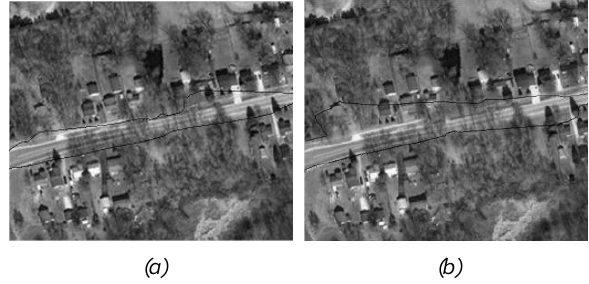
Figure 16:(a) Ziplock Snake with Gaussian Kernel (15x15) (b) Ziplock Snake with Gaussian Kernel (10x10)